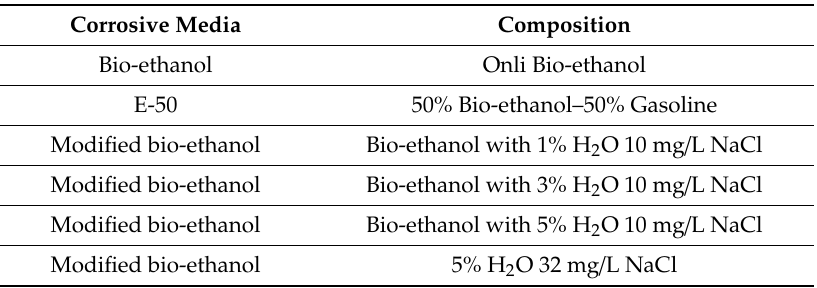
Table 1. Di ff erent corrosive media. Table 1. Different corrosive media.